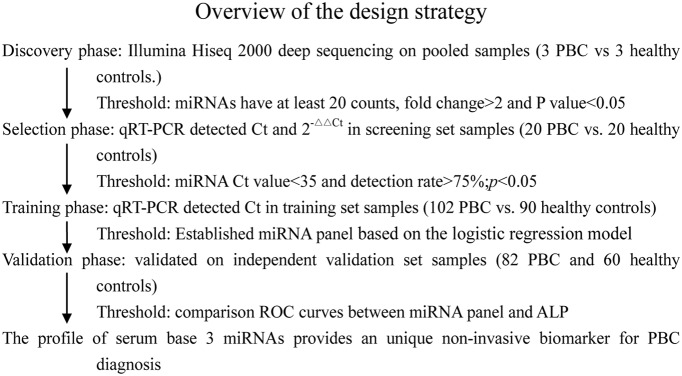
A flow chart of the experimental design.